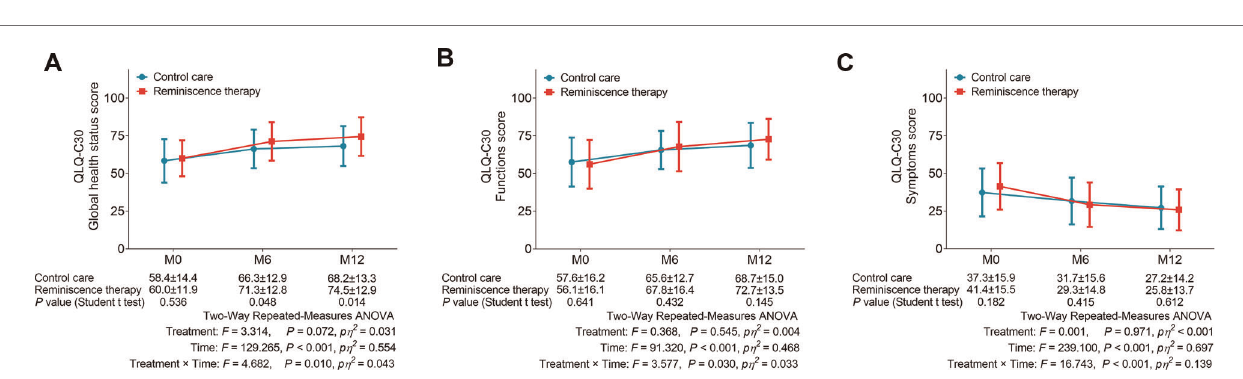
FIGURE 4 | Comparison of the quality of life between the reminiscence therapy group and the control care group. Comparison of the QLQ-C30 global health status score ( A ), QLQ-C30 function score ( B ), and QLQ-C30 sympto score ( C ) between groups at each visit point.